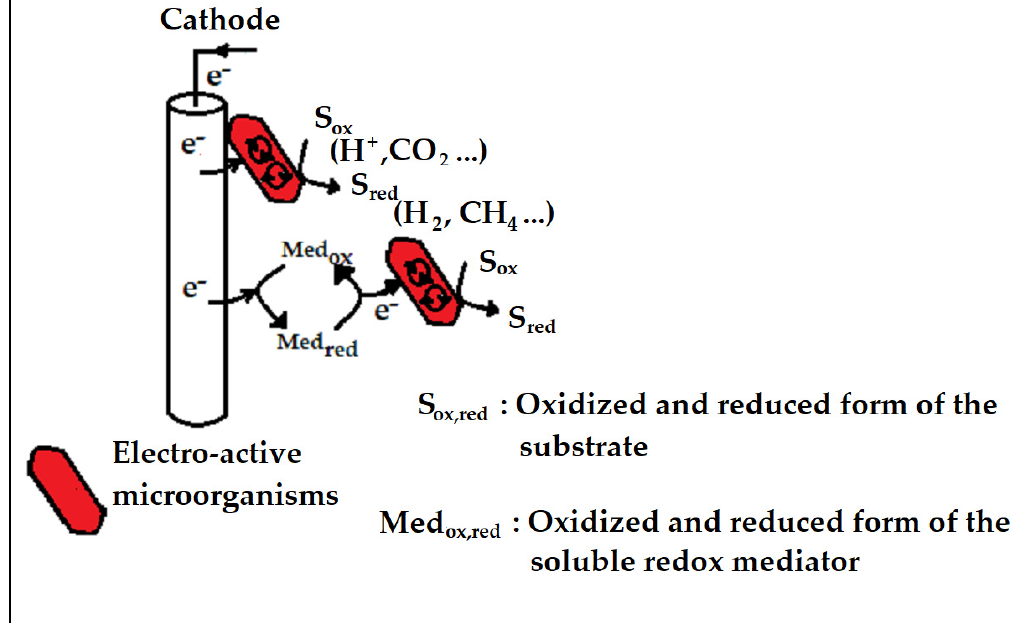
Figure 10. Schematic diagram of the mechanism generated in a bio-cathode. Adapted from